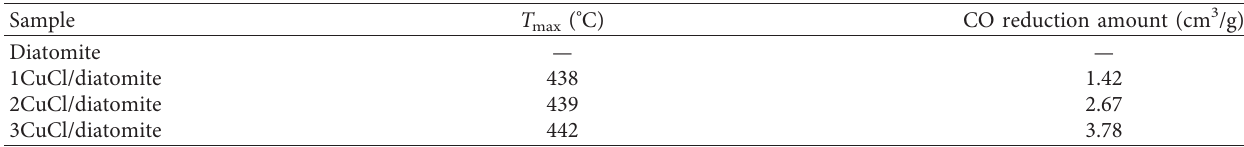
Table 3: CO reduction temperature and CO reduction amount of CuCl-modified diatomites.